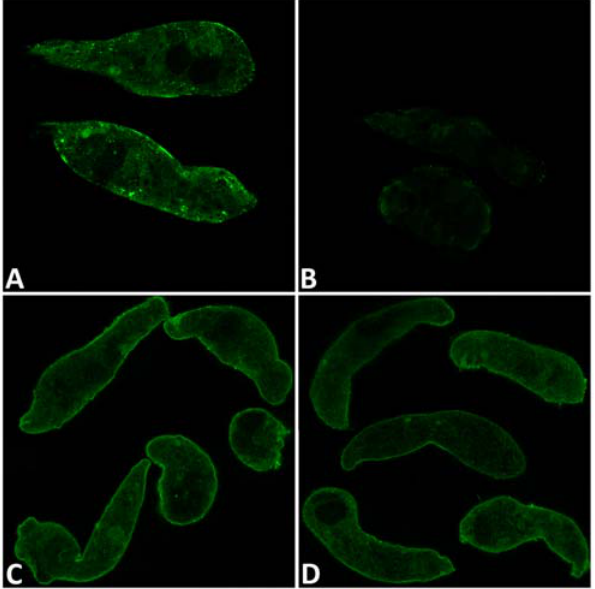
Figure 2. Representative confocal epifluorescent photomicro- graphs of Schistosomamansoni sporocysts showing immunolo- calization of anti-GST26 and anti-Prx1 antibodies after culti- vation in medium containing GST26, Prx or control GFP dsRNA. Fluorescence specific to anti-GST26 reactivity (green) observed in GST26 dsRNA-treated larvae (Fig. 2B) was noticeably reduced compared to the nonspecific GFP dsRNA control sporocysts (Fig. 2A), consistent with the high protein knockdown ( , 80%) seen in Western blot analysis. By contrast, little difference in fluorescence levels was observed between the nonspecific GFP dsRNA control-treated (Fig. 2C) and Prx1/2 dsRNA-treated (Fig. 2D) sporocysts, reflecting the relatively small decrease ( , 50%) observed in immunoblot protein levels. N=3.